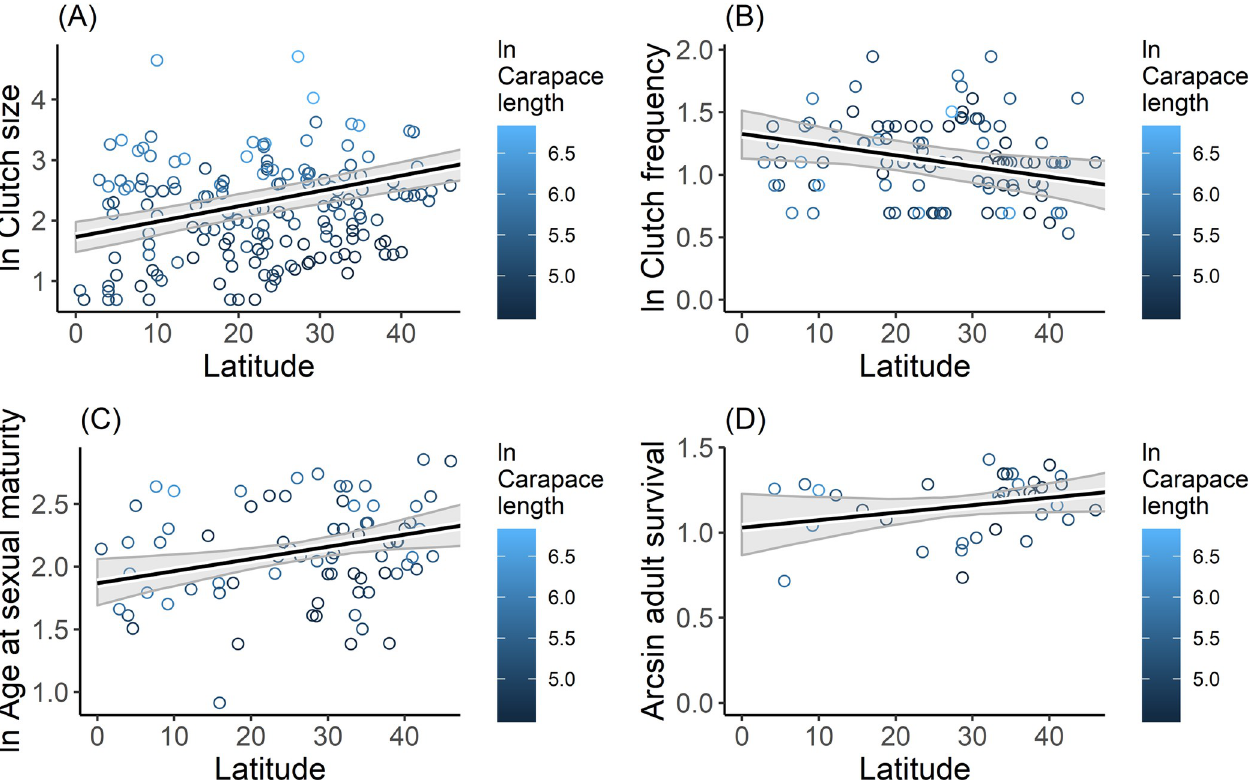
Fig 3. Relationships between latitude and (A) clutch size, (B) clutch frequency, (C) age at sexual maturity, and (D) adult survival rate of freshwater turtles. Points are the median species values obtained from the literature (S1 Table), colored representing ln carapace length values. Solid black line is the GAM prediction. Grey shaded polygons show 95% confidence bands around the